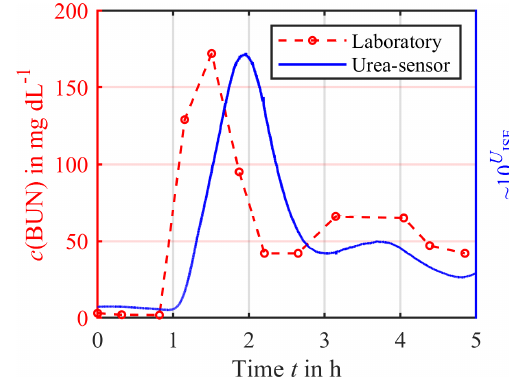
Figure 8. Continuously measured urea concentration using the am- monium ISE (solid blue line) compared to the laboratory analysis (red